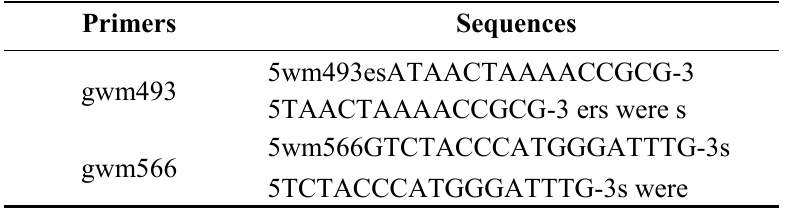
Table 3. Specific primer sequences used for PCR